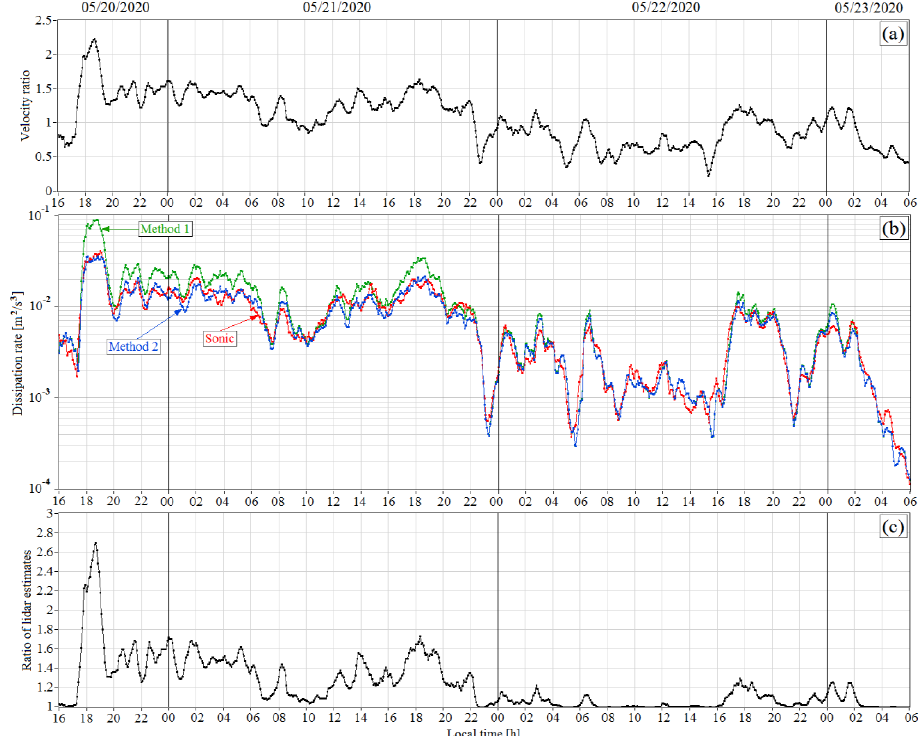
Figure 10. Time series at a height of 42 m for ( a ) the ratio µ of the mean wind velocity to the linear speed of motion of the probing volume, ( b ) the turbulence energy dissipation rate calculated from lidar data by Method 1 (green curve) and Method 2 (blue curve) and from data of sonic anemometer (red curve) and ( c ) the ratio of lidar estimates of the dissipation rate calculated by Methods 1 and 2. Measurements at the BEO started from 16:00 LT on May 20 of 2020.